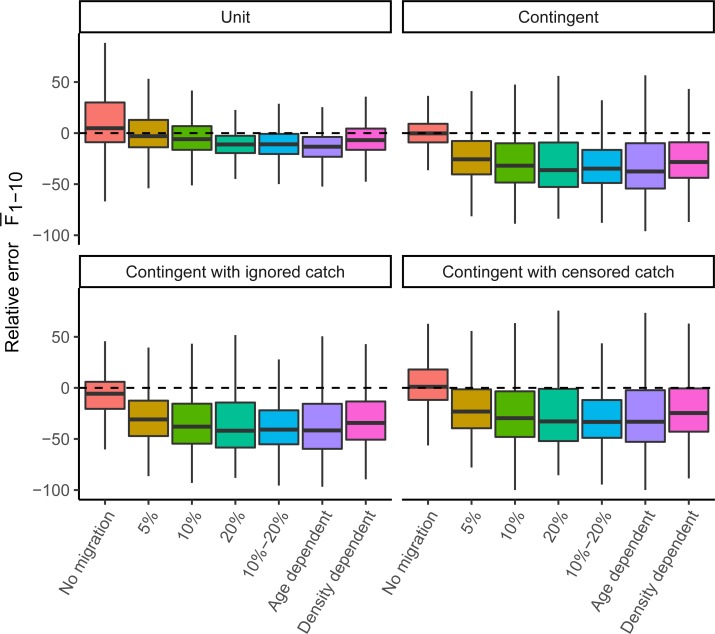
Boxplots of relative error (RE, %) in F1–10 by the four standard estimations models (panels) based on pseud-data generated by seven operating models (Table 2).The dashed line indicates zero or no error.